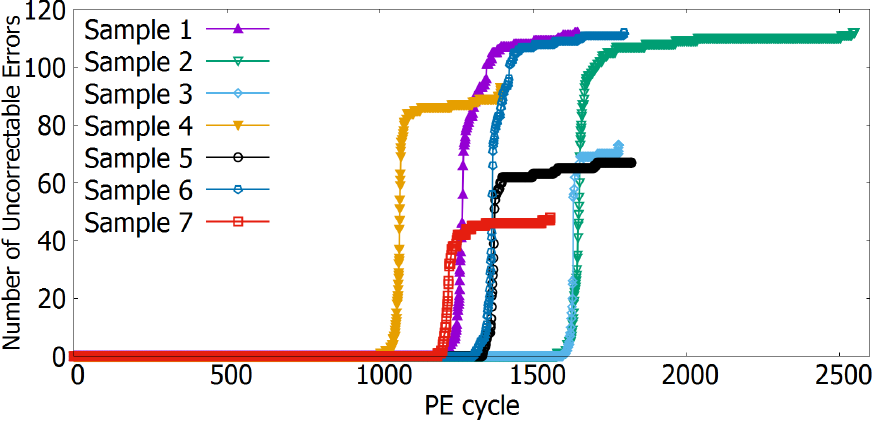
Figure 7. P/E(program/erase) cycles and Uncorrectable